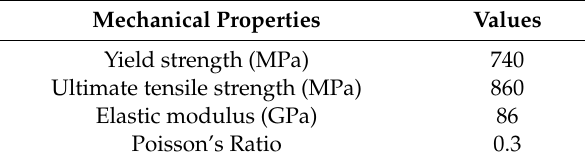
Table 1 . The mechanical properties of Ti-27Nb [19]. Table 1. The mechanical properties of Ti-27Nb [19].